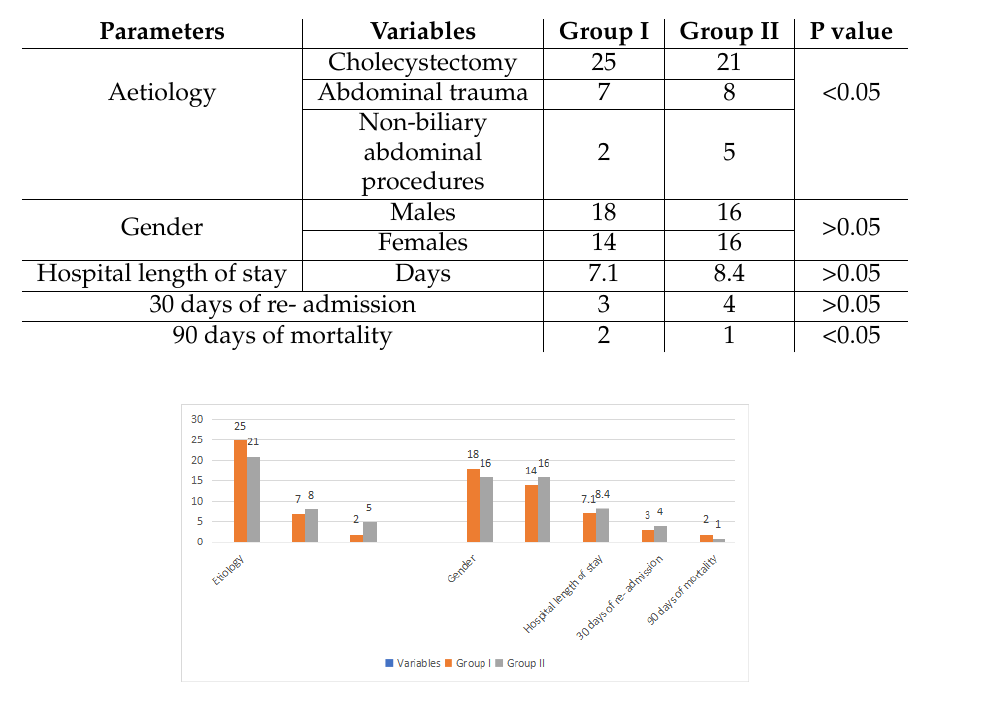
Figure 1. Graphically comparison of